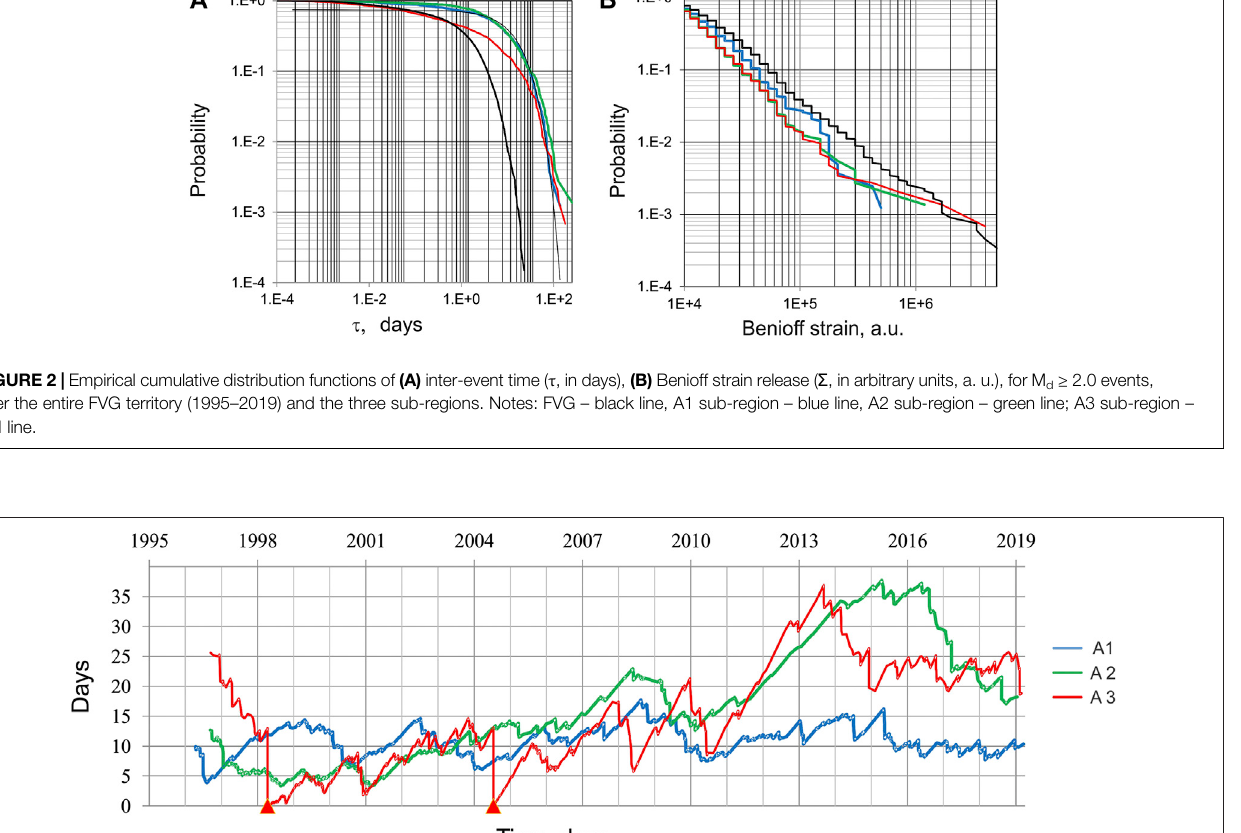
FIGURE 3 | Inter-event time ( τ , in days) vs. earthquake origin time, for the three sub-regions of FVG territory (1995 – 2019). A1 – blue line, moving average for 50 earthquakes; A2 – greenline,moving averagefor50events; A3 – red line,moving averagefor25earthquakes. Theorigintimeofthetwoprincipal earthquakes ( Table 2 ) are marked with red triangles on the origin time scale.